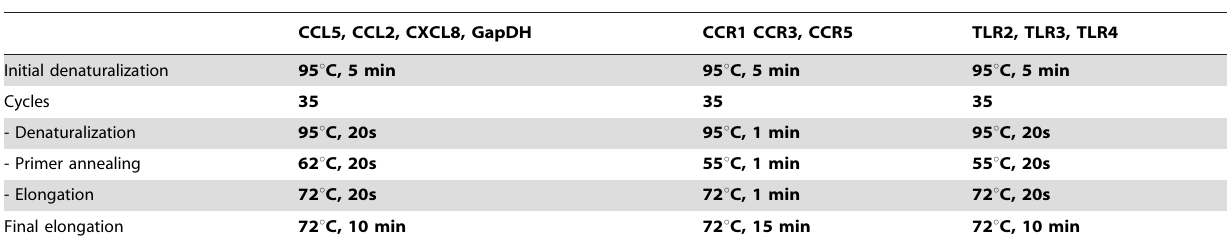
Table 2. Description of the PCR amplification